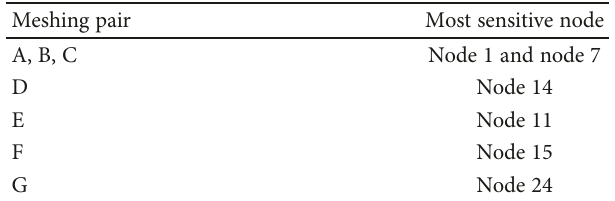
Table 2: Sensitivity correspondence of wall